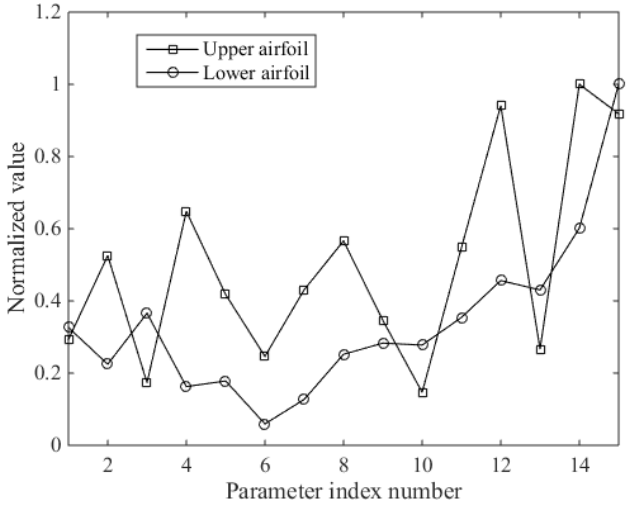
Figure 14. Normalization of parameterization matrix values.